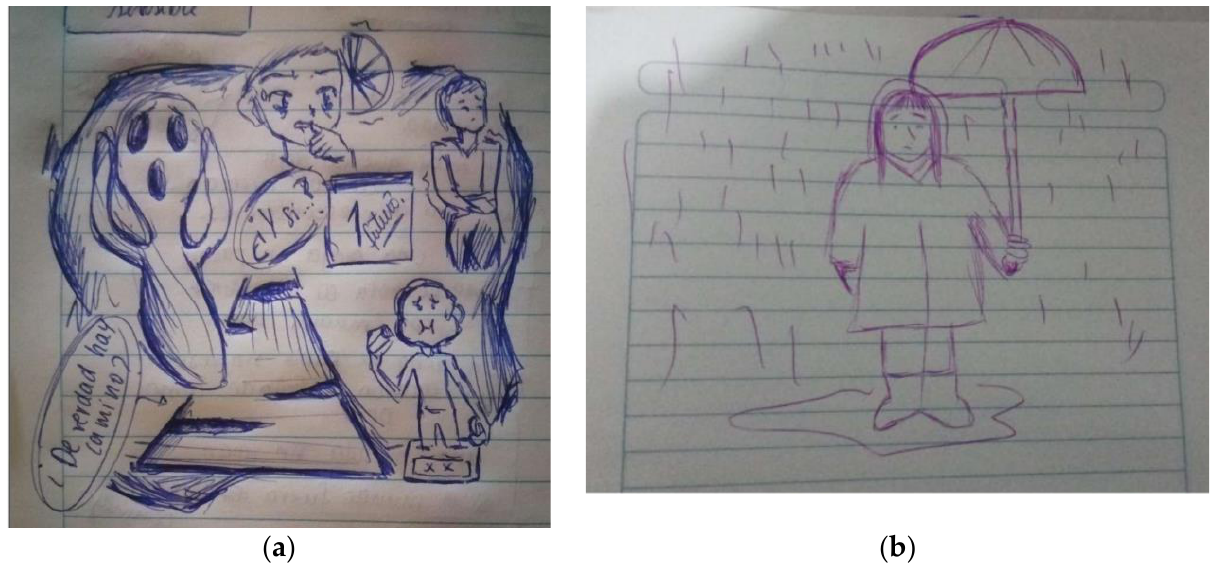
Figure 2. ( a , b ) Images of anxiety and depression drawn by an adolescent and a young adult. Participants worked on 17 lifelines using threads, markers, and pens (see Figure